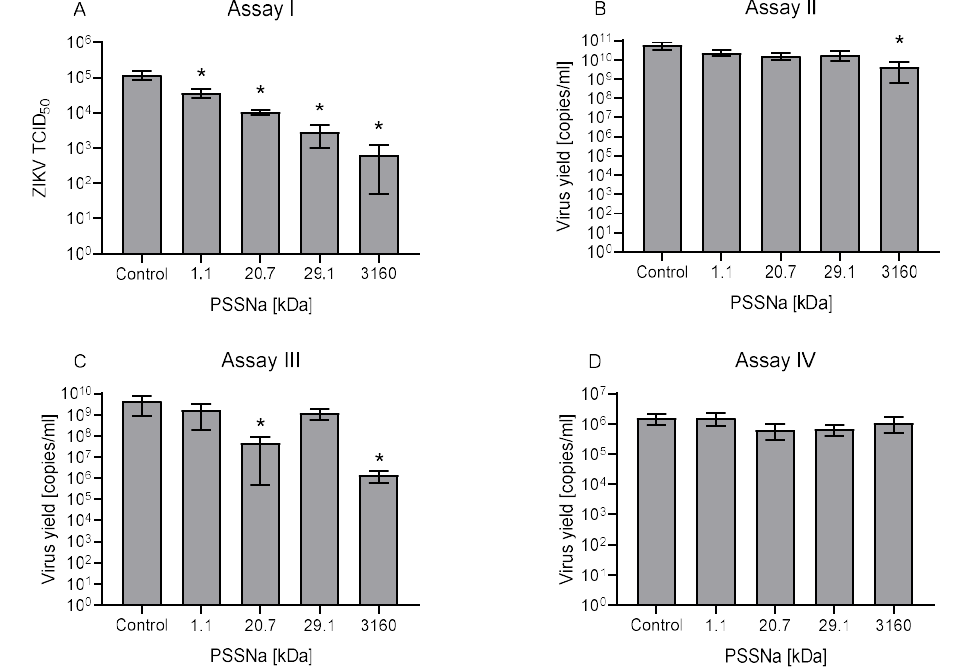
Figure 5. PSSNa interacts with ZIKV particles and blocks their interaction with the receptor. Inhibitory activity of PSSNa of di ff erent MW at di ff erent stages of ZIKV infection cycle. Functional Assays I–IV were carried out on U251 cells as described in the Materials and Methods section using H / PF / 2013 strain after the virus inactivation Assay I (Assay I, ( A )), where the virus was pre-incubated with polymers, diluted and titrated on U251 cells. Modulation of virus yield as determined by RT-qPCR after the Cell protection assay (Assay II, ( B )); Attachment assay (Assay III, ( C )); or Virus replication, assembly, and egress assay (Assay IV, ( D )). The inhibition of the infection was evaluated using RT-qPCR. All experiments were performed in triplicate. The results are presented as average values with standard deviations (error bars). An asterisk ( p < 0.05) indicates values that are significantly di ff erent from the